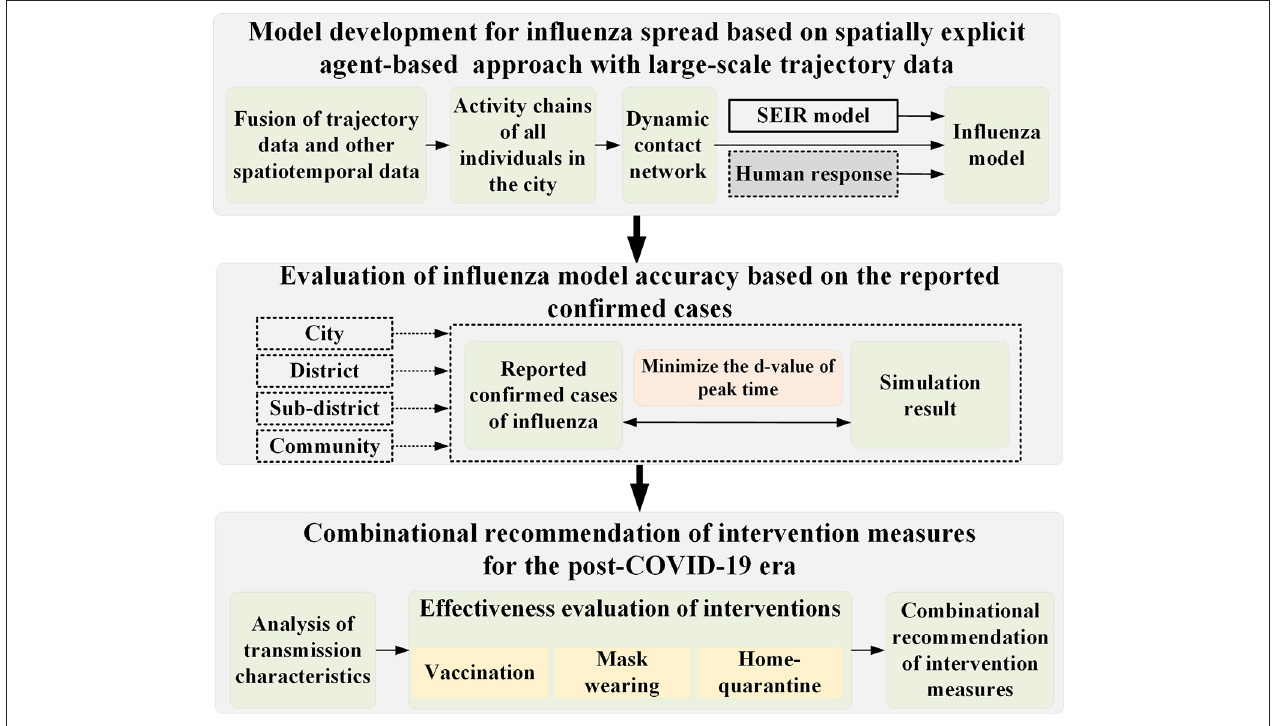
FIGURE 2 | The overall research framework of this